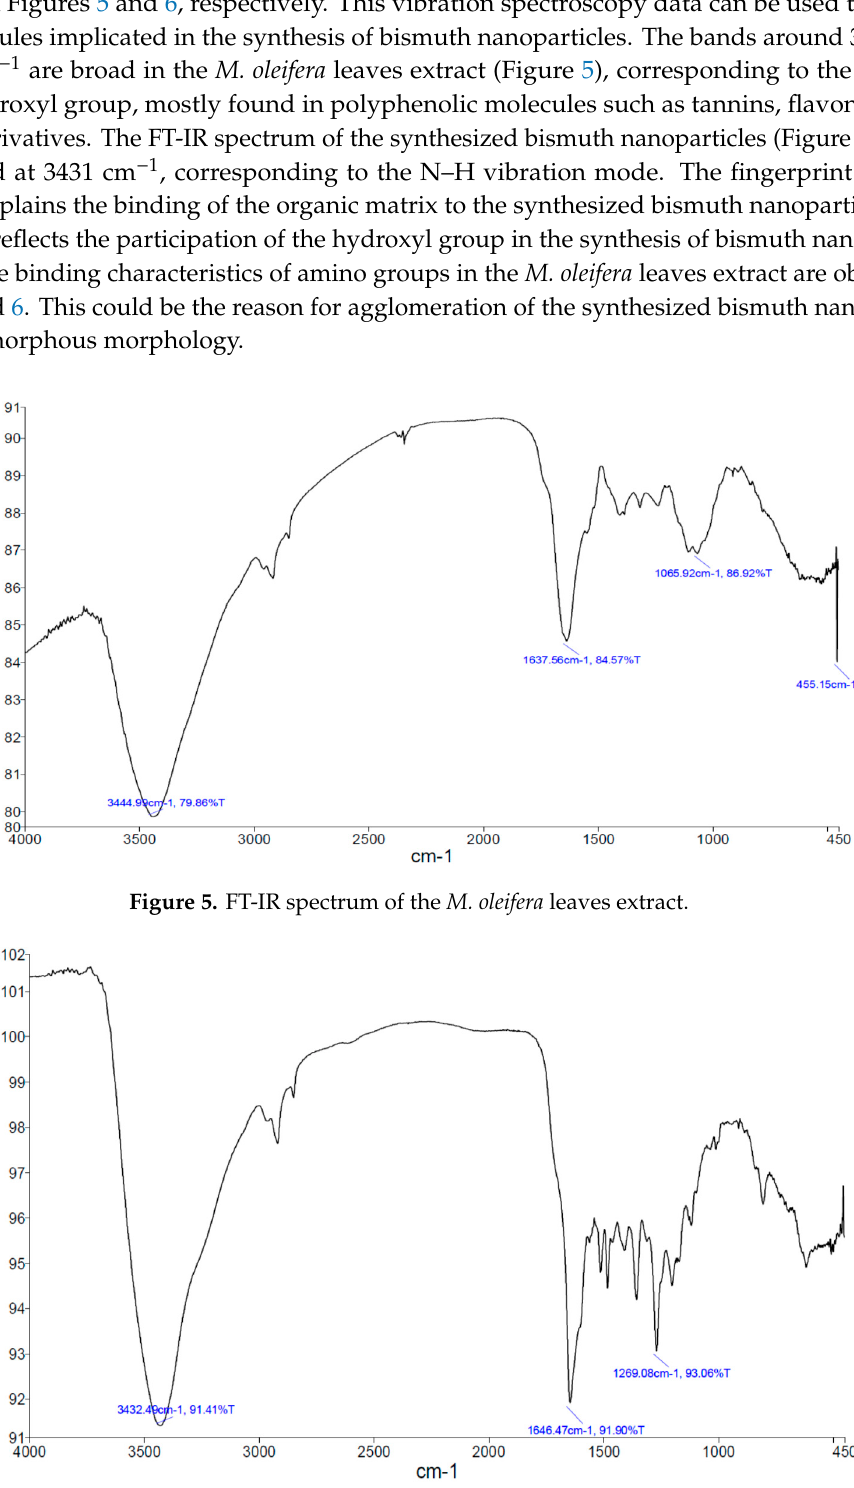
Figure 6. FT-IR spectrum of the synthesized bismuth nanoparticles.